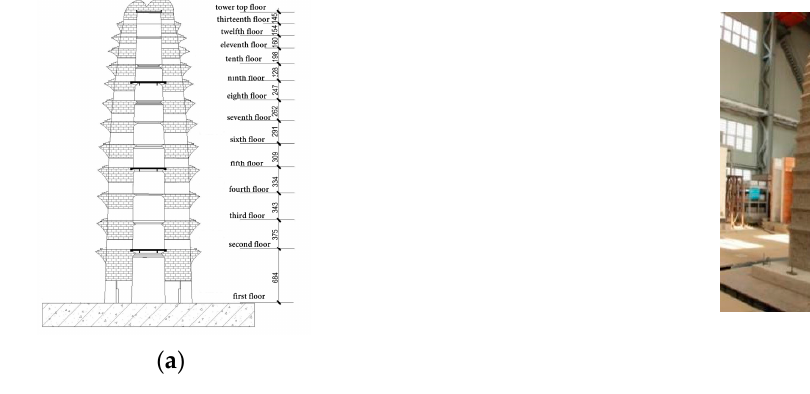
Figure 3. Tower dimensions and overall model. ( a ) Tower size; ( b ) Overall model.